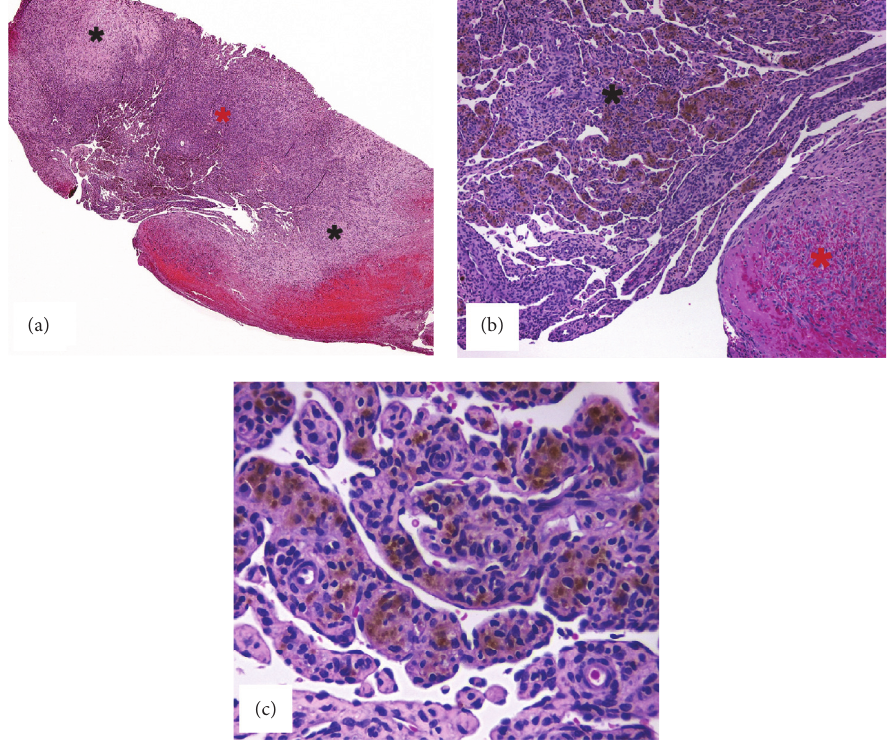
Figure 2: Histopathological findings of IPEH. (a) Photomicrograph showing thrombus in organization in the peripheral region (black stars) and intravascular papillary endothelial proliferation in the central region (red star) (H&E, × 4). (b) Close relationship between papillae structures in association with hemosiderin deposition (black star) and the thrombus (red star) (H&E, × 10). (c) Close-up of reactive papillary endothelial proliferation containing hemosiderin deposits (H&E, ×